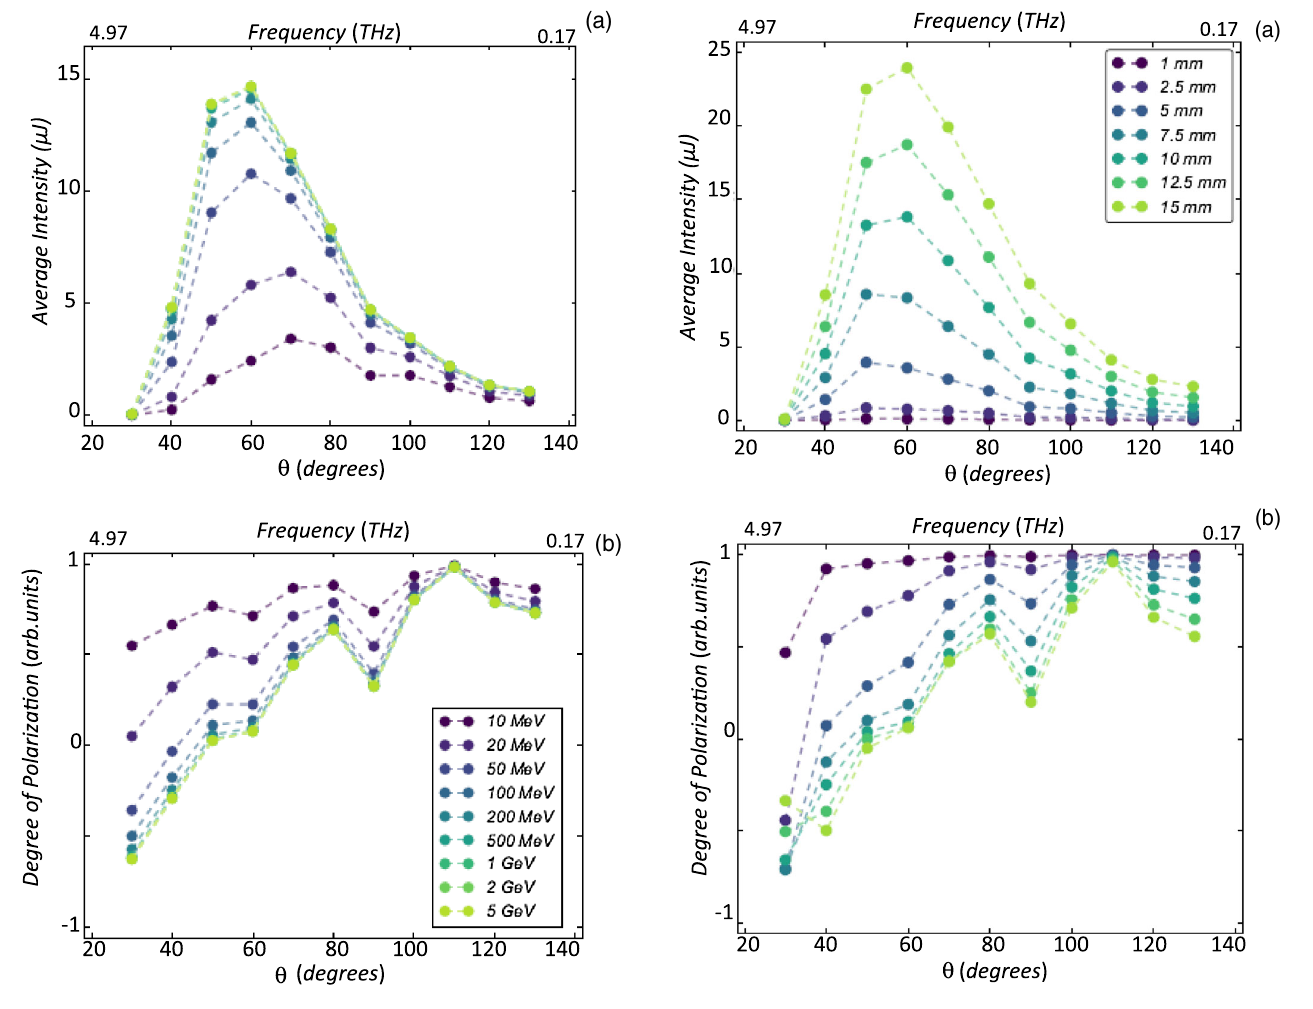
FIG. 9. Figures showing: (a) the calculated average intensity and (b) DoP of cSPr generated by electron bunches of varying energies, as shown in the inset of (b). The markers on each graph represent the location of the detectors along the θ coordinate (all detectors are located at φ ¼ 0 ). The values given for the average intensity have been integrated over the detector aperture.